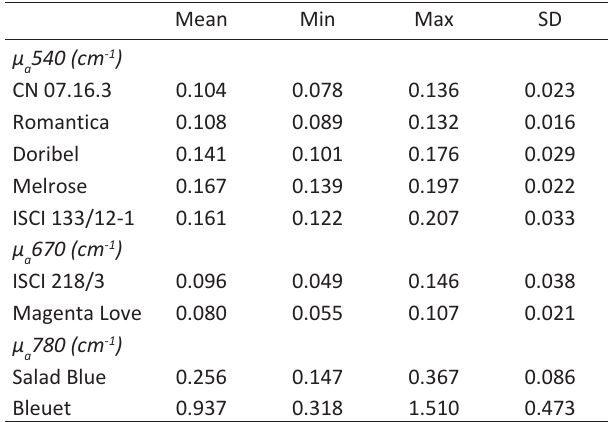
Table 2 ­ Values of the absorption coefficients measured by TRS at 540 nm (µ 540), 670 nm (µ 670) and 780 nm (µ a a used to rank white­yellow, red and purple